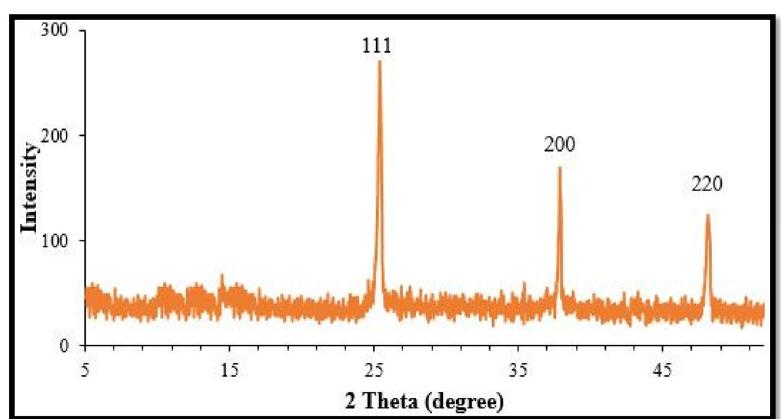
Figure 4: XRD spectroscopy of green - synthesized AgNPs.